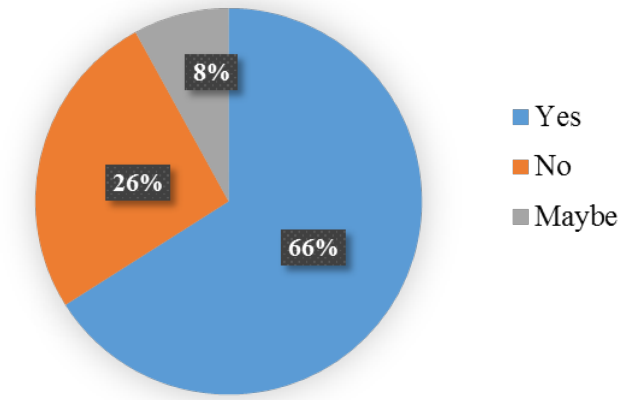
Figure - 13: Showing the school/college/university/institution provides training for online